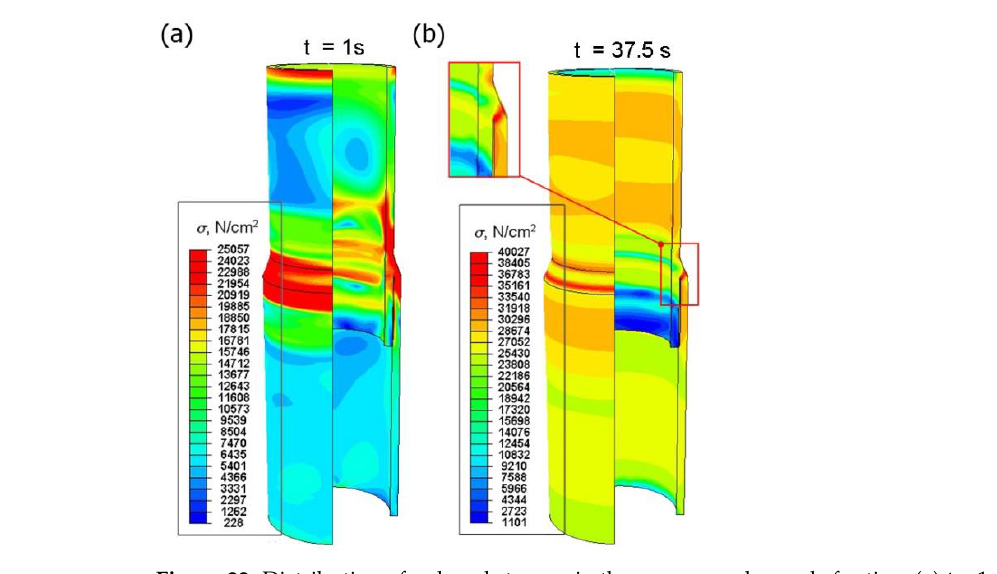
Figure 22. Distribution of reduced stresses in the compressed sample for time ( a ) t = 1 s, ( b ) t = 37.5 s.